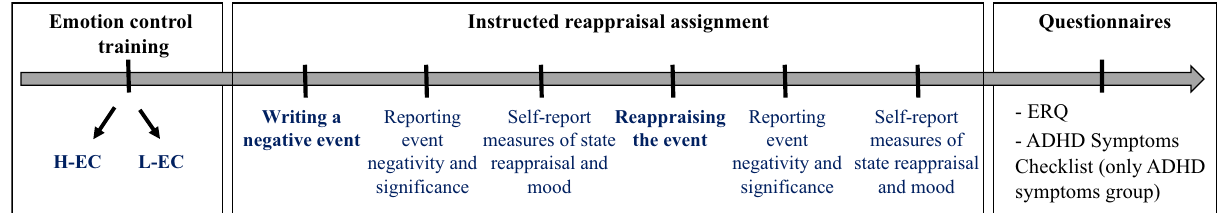
Figure 1. Overall study design. Participants first completed the training task. They were randomly assigned to either the H-EC or the L-EC condition. They then performed the instructed reappraisal assignment. Finally, they completed the Emotion Regulation Questionnaire (ERQ). Participants in the ADHD symptoms group also answered the ADHD Symptoms Checklist.